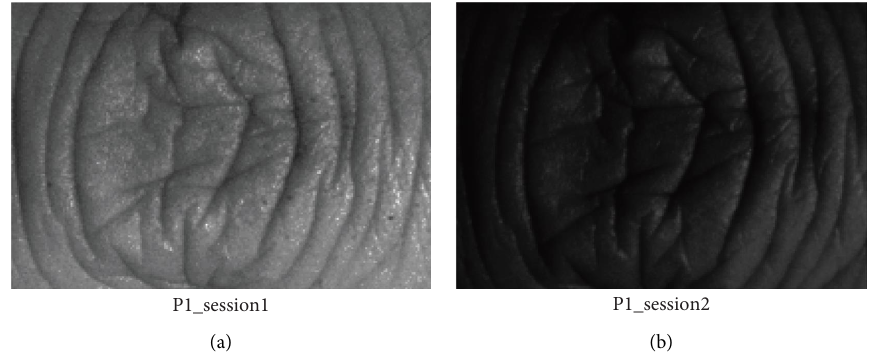
Figure 1: 3D fnger knuckle examples. (a) P1_session1, (b) P1_session2.